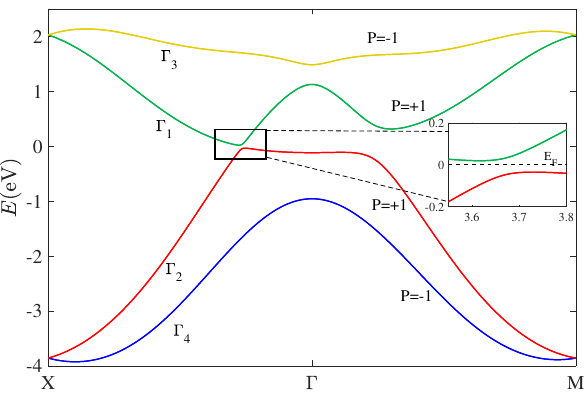
Figure 4: (Color online) Energy dispersion of the bulk bands of the monolayer WTe 2 along the X- Γ -M k path. The middle two bands have the same parity eigenvalue P = 1. This indicates that the band inversion occurs between the first conduction = 40 and second valence band. We have taken V (cid:48) 0